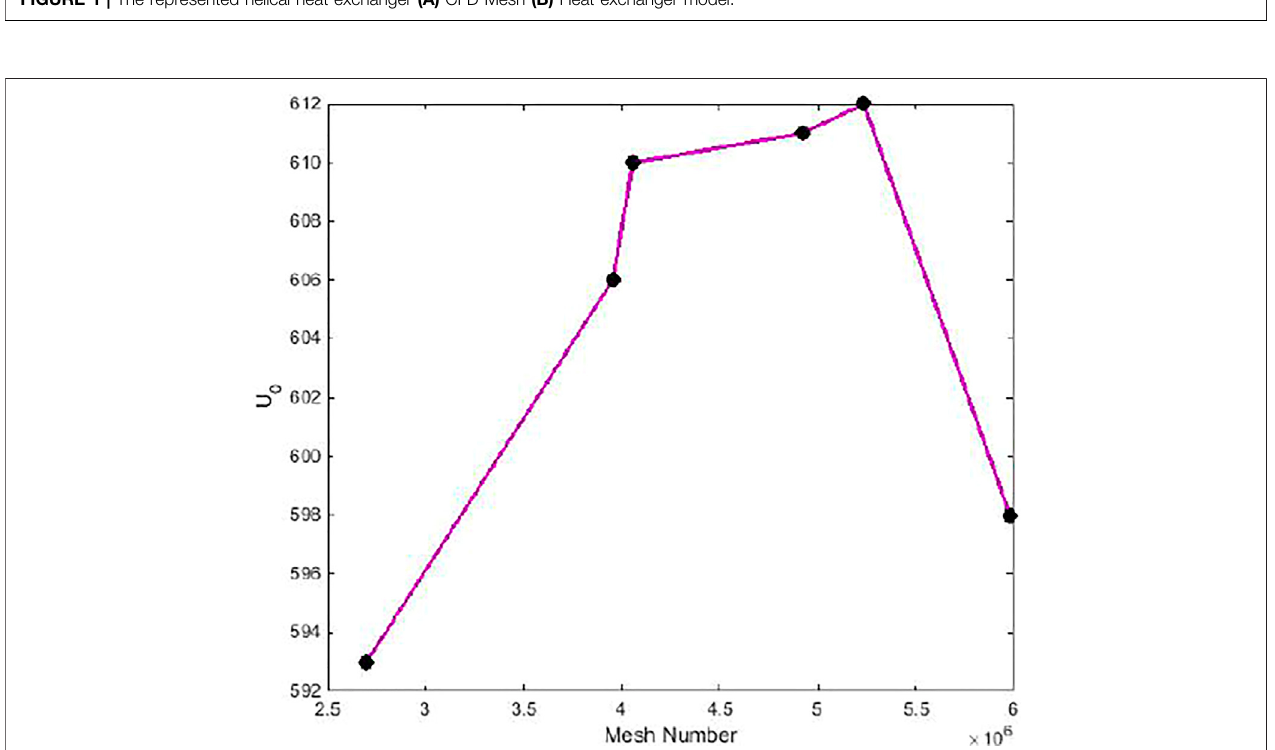
FIGURE 2 | Mesh convergences